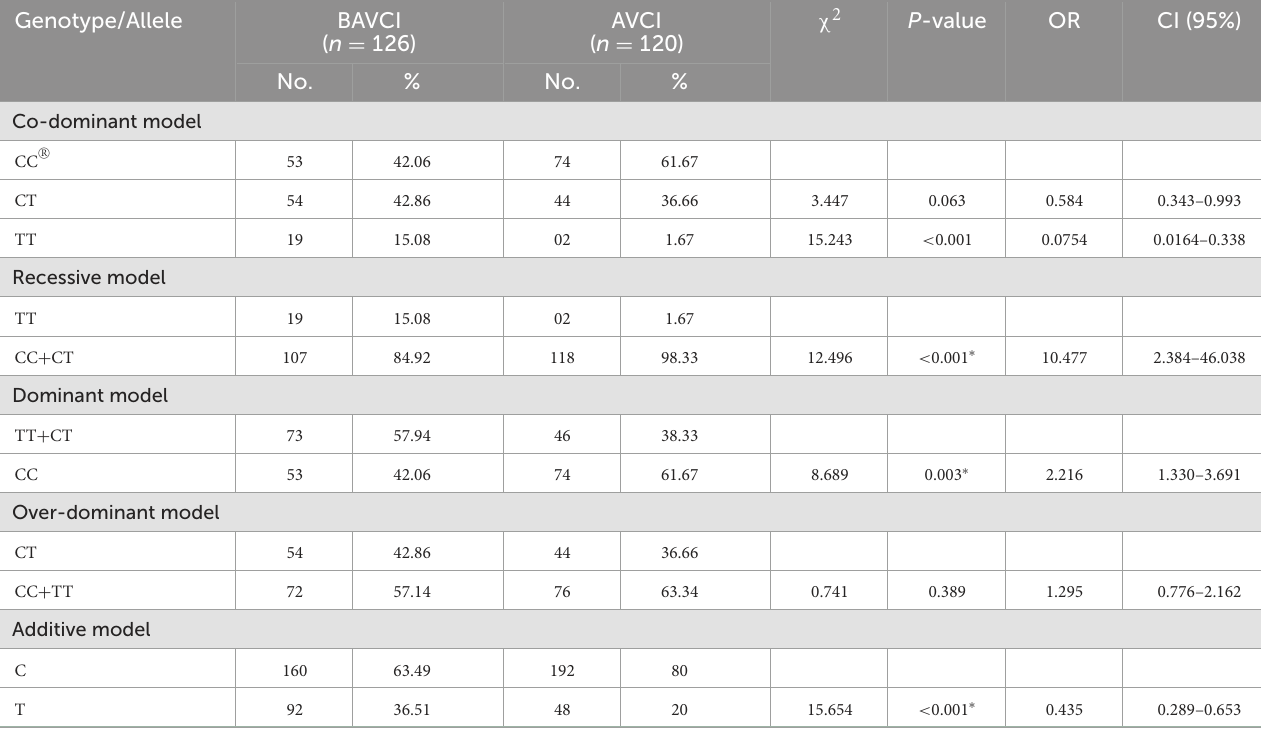
TABLE 2 BDNF gene polymorphism under co-dominant, recessive, dominant, over-dominant, and additive models in individuals with below average VCI (BAVCI) and average VCI (AVCI). Genotype/Allele